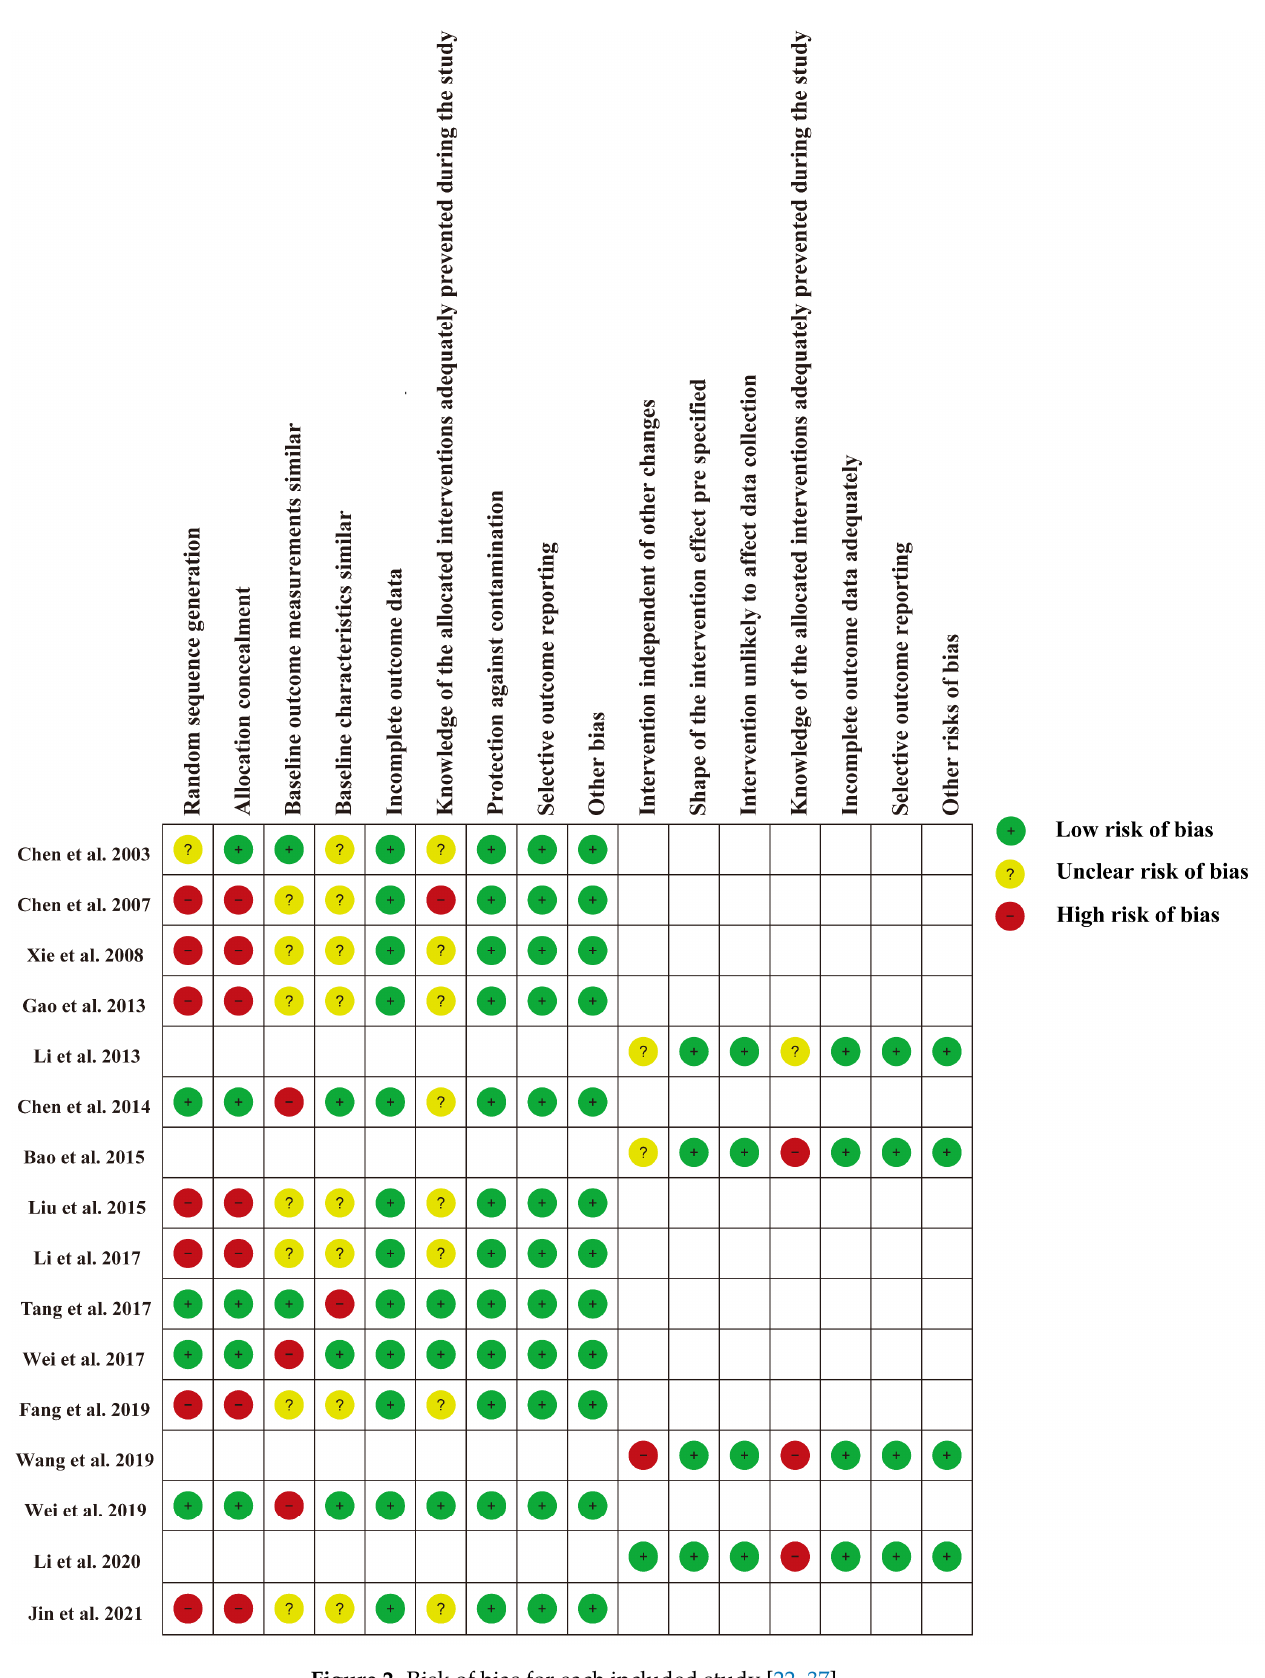
Figure 2. Risk of bias for each included study [22–37] .